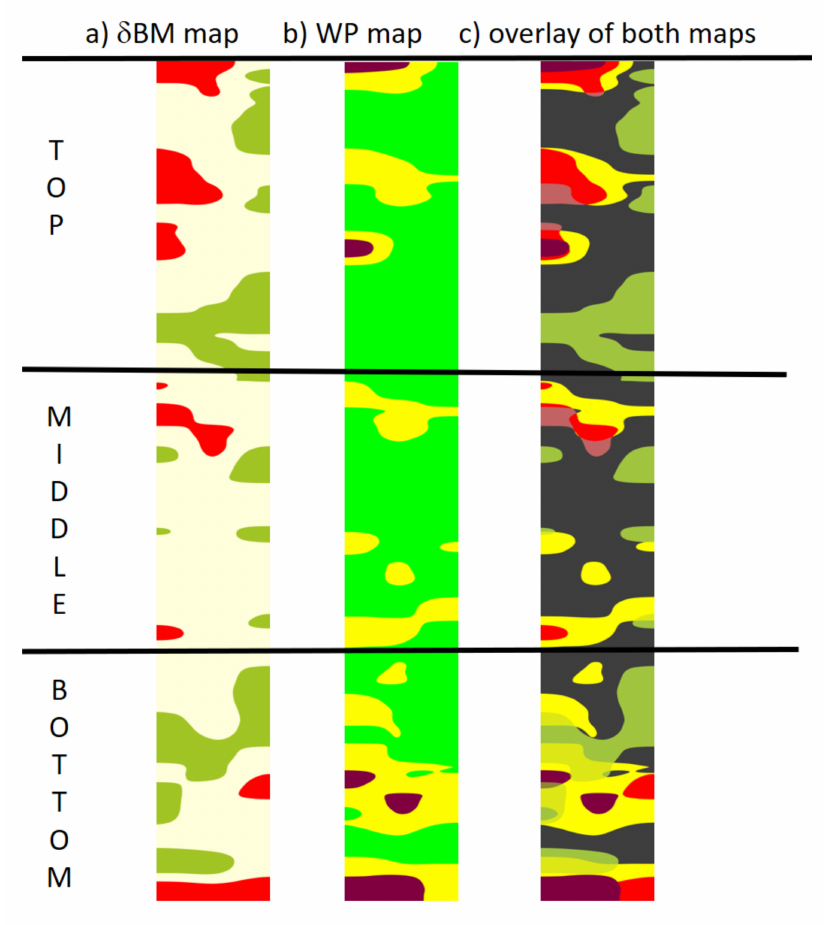
Figure 8. Date 1: ( a ) δ BM map; ( b ) WP map; ( c ) Comparison between the two